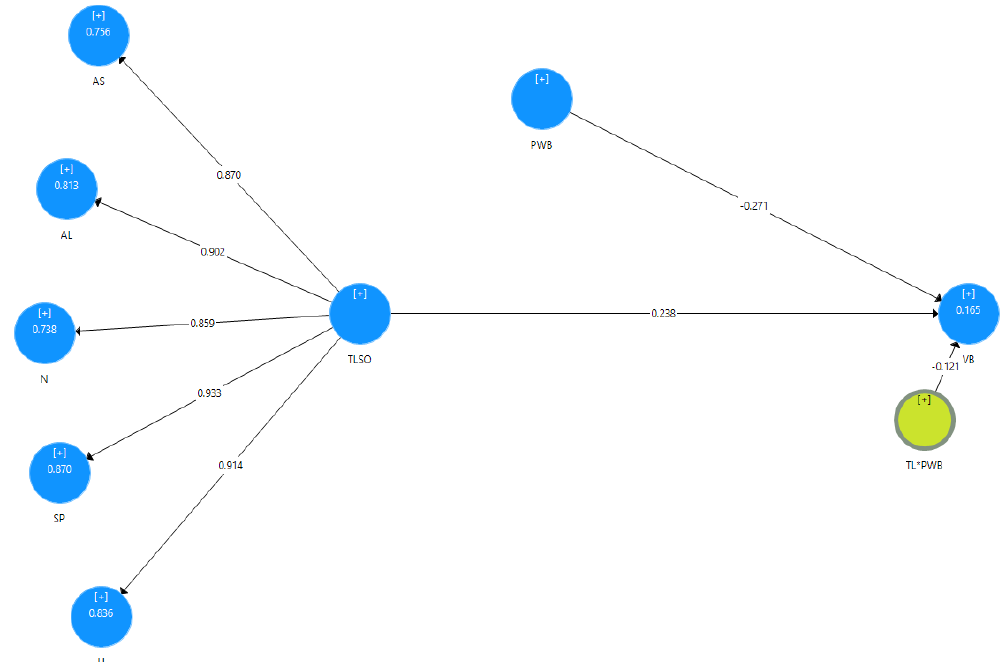
Figure 1. Path Analysis of Toxic Leadership and Psychological Well-Being predicting Vengeful Behaviors. Notes: AS = Abusive Supervision; AL = Authoritarian Leadership; N = Narcissism; SP = Self-Promotion; U = Unpredictability; TLSO = Second-order Toxic Leadership; PWB = Psychological Well-Being; VB = Vengeful Behaviors.